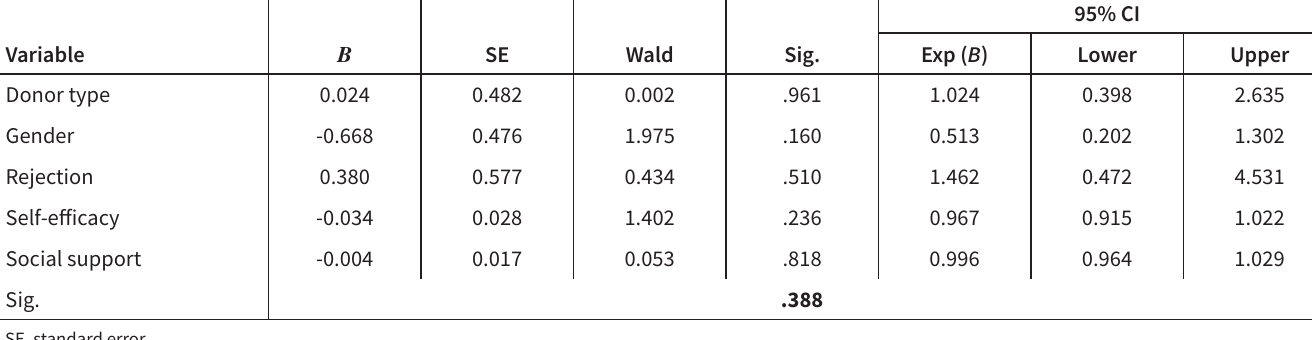
Table 4. Factors Affecting Medication Adherence According to Biological Assay (n =